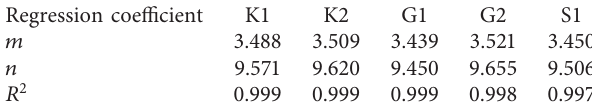
Table 3: Viscosity-temperature curve regression